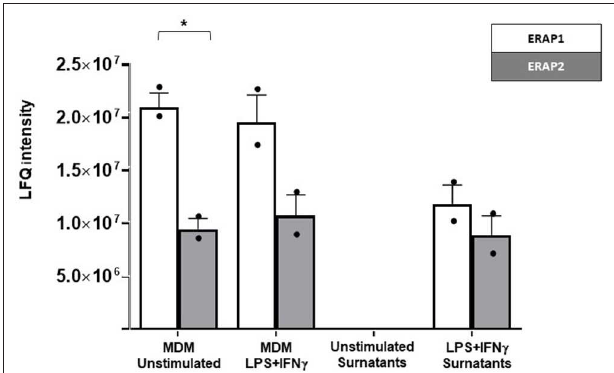
FIGURE 1 | Label free quantitation (LFQ) intensity of ERAP2 and ERAP1 in unstimulated and LPS/IFN- γ stimulated MDMs from HomoA subjects and in related cell media. ERAP1 (white bars) was generally more expressed than ERAP2 (gray bars), with a statistical p -value of 0.02 in unstimulated cells. ERAP1 and ERAP2 were not secreted by unstimulated MDMs but only in response to macrophage activation by LPS/ IFN γ . Mean values and SEM are shown. * p <